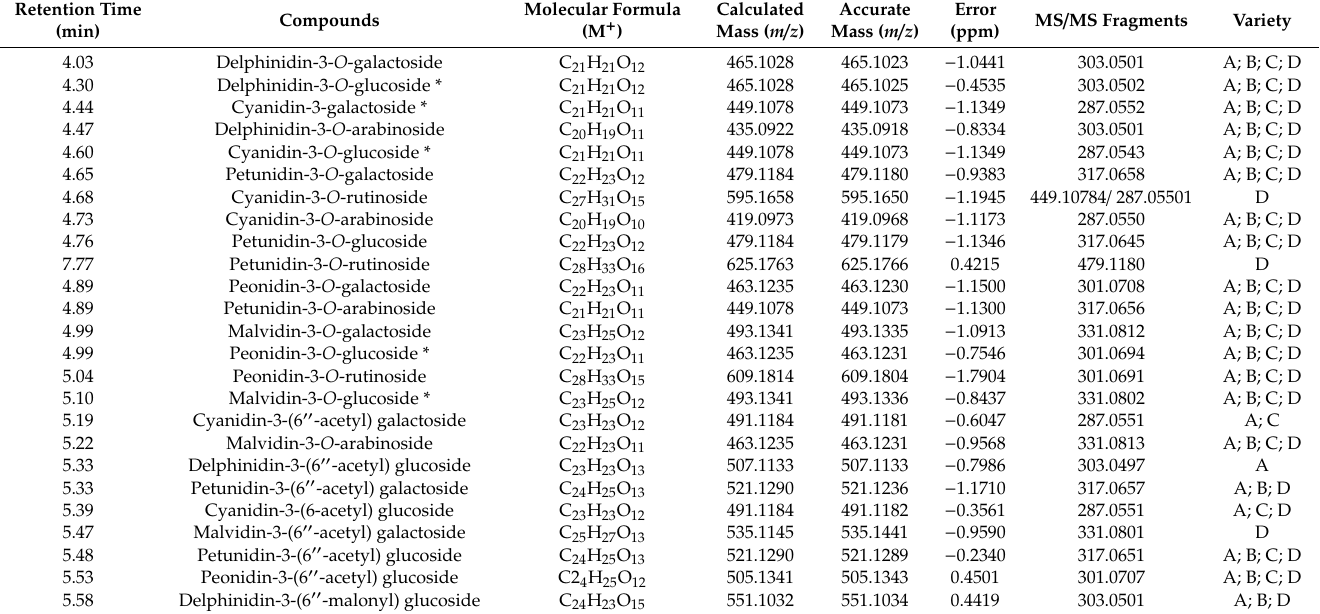
Table 3. Tentative identification of di ff erent anthocyanins in the blueberry varieties